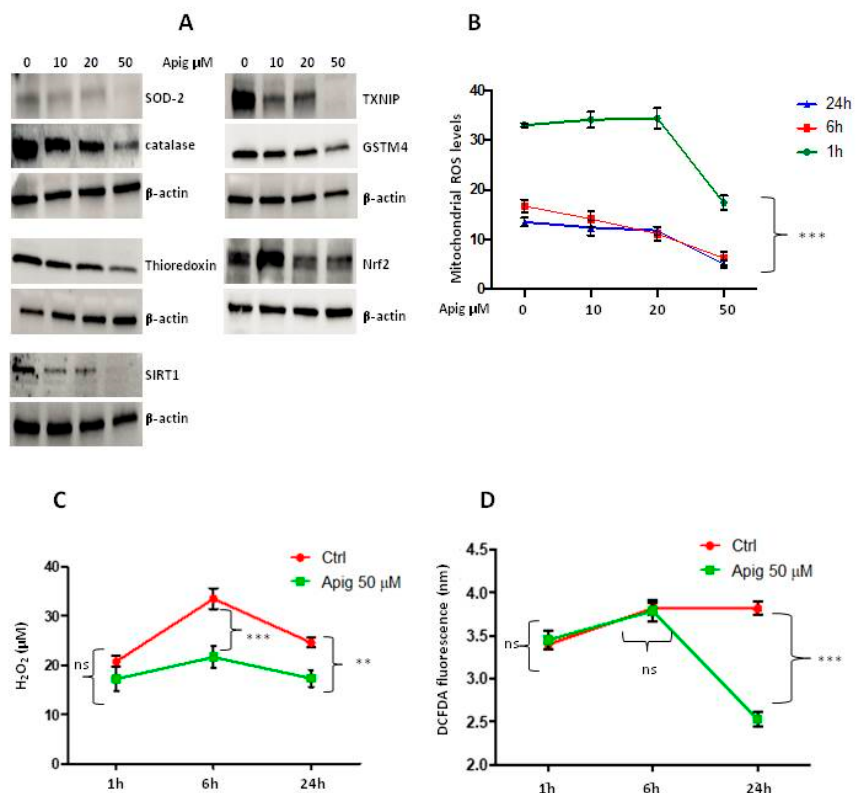
Figure 2. ( A ) WB analysis of apigenin e ff ect on antioxidants expression: SOD2, Catalase, Thioredoxin, SIRT1, TXNIP, GSTM4, Nrf2 with β -actin as loading control; ( B ) E ff ect of apigenin after di ff erent